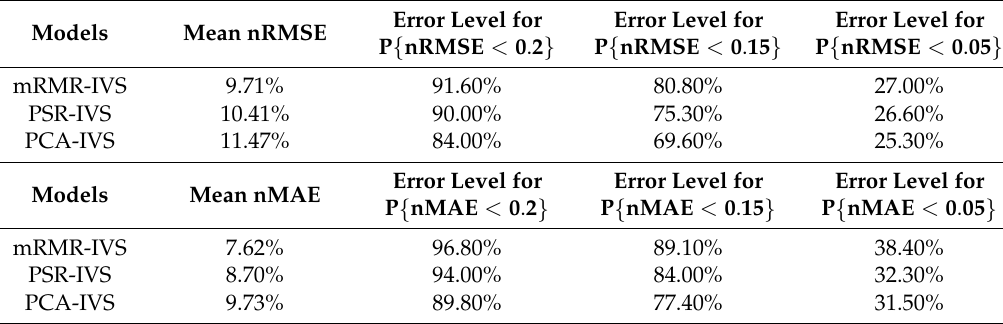
Table 7. Mean errors and probability distributions of Xuqiao